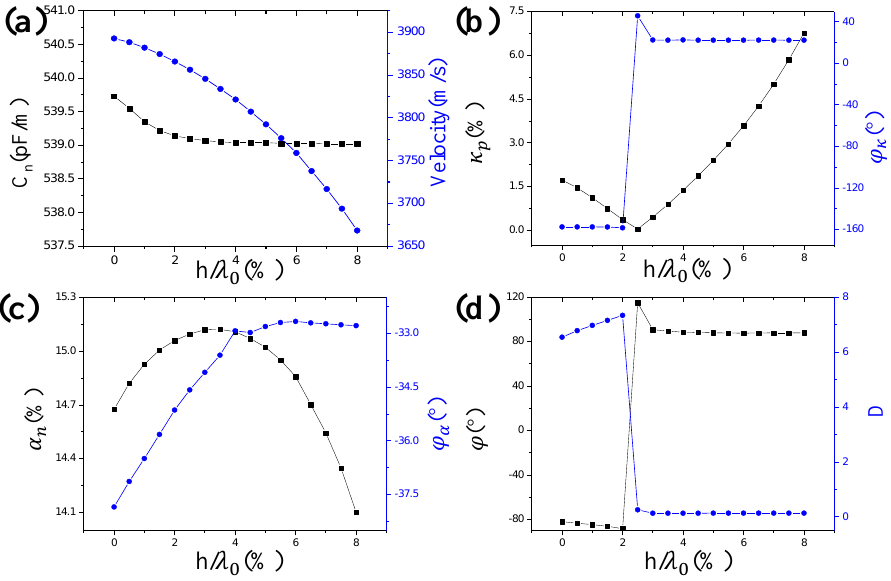
Figure 7. COM parameters versus thickness of electrode for EWC SPUDT on 128°YX-LiNbO 3 : ( a ) Normalized capacitance and velocity; ( b ) Reflection coefficient and its phase; ( c ) Normalized transduction coefficient and its phase; ( d ) The unidirectional angle and directivity.